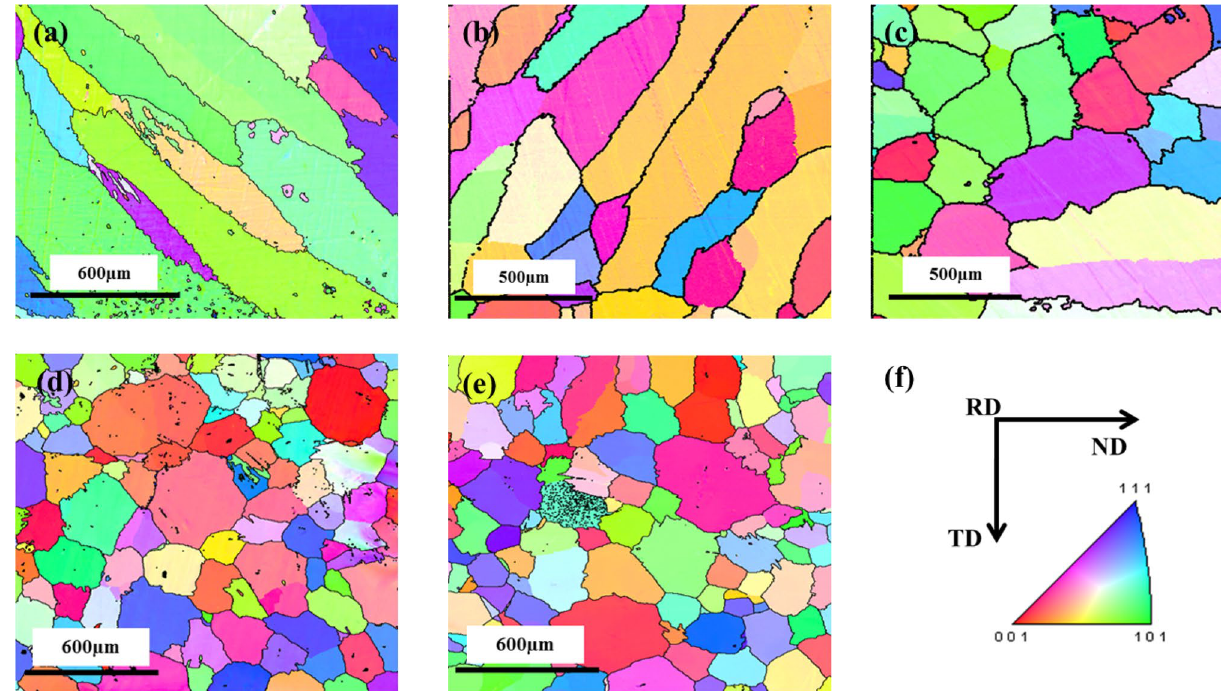
Figure 3. IPF maps of ( a ) Cast 1, ( b ) Cast 2, ( c ) Cast 3, ( d ) Cast 4, ( e ) Cast 5 and ( f ) directions of the slab ingot with respect to the scanned surface.